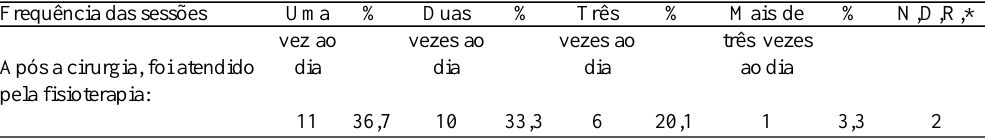
Tabela 3. Questionamento relacionado à frequência das sessões. Frequência das sessões